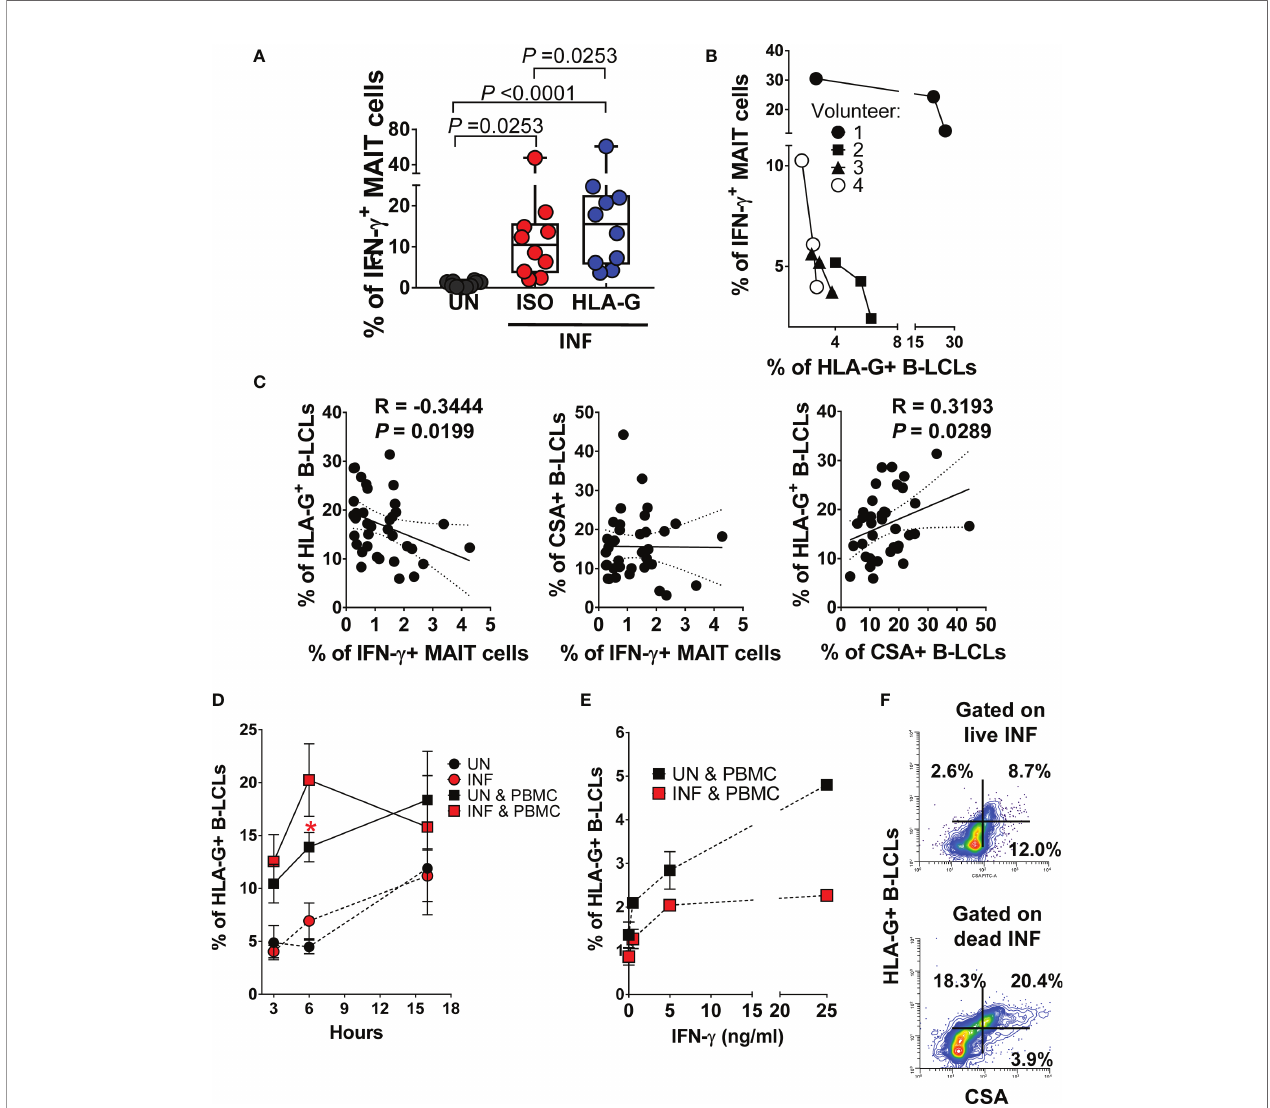
FIGURE 3 | Effect of HLA-G expression on MAIT cell function. B-LCLs were infected with S . Typhi for 3 hours. Uninfected cells were used as controls. (A) PBMC were exposed to either uninfected (UN) or S . Typhi-infected (INF) B-LCL cells treated with Abs to HLA-G (HLA-G) or isotype (ISO) control (2.5 m g/ml). After 16-18 hours of co- culture, cells were collected, and the levels of MAIT cells expressing IFN- g were evaluated by fl ow cytometry. Data are representative of two independent experiments. Bar graphs extend from the 25 th to 75 th percentiles; the line in the middle represents the median of the pooled data. The whiskers delineate the smallest to the largest value. (B) Relationship between the levels of IFN- g + MAIT cells and HLA-G expression on B-LCLs evaluated by mass cytometry. Four individual volunteers were studied under 3 different conditions (UN, ISO, and HLA-G). (C) Pearson ’ s correlations among levels of HLA-G and S . Typhi antigen (CSA) expression on B-LCLs and IFN- g production by MAIT cells. Data are representative of at least fi ve individual experiments. (D) Kinetics of HLA-G expression on B cells cultured alone (UN and INF) or cocultured with PBMC (UN & PBMC, and INF & PBMC). Data are representative of 3 individual experiments with 2-3 replicates Student ’ s t-test was performed to compare HLA-G+ B- LCL cell levels after exposure to MAIT cells. *, represent signi fi cant differences ( P <0.05) between the uninfected ( ) and infected B-LCLs ( ) in the presence of MAIT cells at the same timepoint. (E) Dose effect of 3 concentrations of recombinant IFN- g (0.5, 5, or 25ng/ml) on HLA-G expression on B cells cocultured for 18 hours with PBMC (UN & PBMC, and INF & PBMC). Co-cultures in the absence of IFN- g (i.e., 0) were used as controls. Data are representative of 1 individual experiment with 2 replicates. (F) Expression of HLA-G vs . CSA on live (upper panel) and dead (lower panel) INF B-LCLs after 16-18 hours of co-culture with